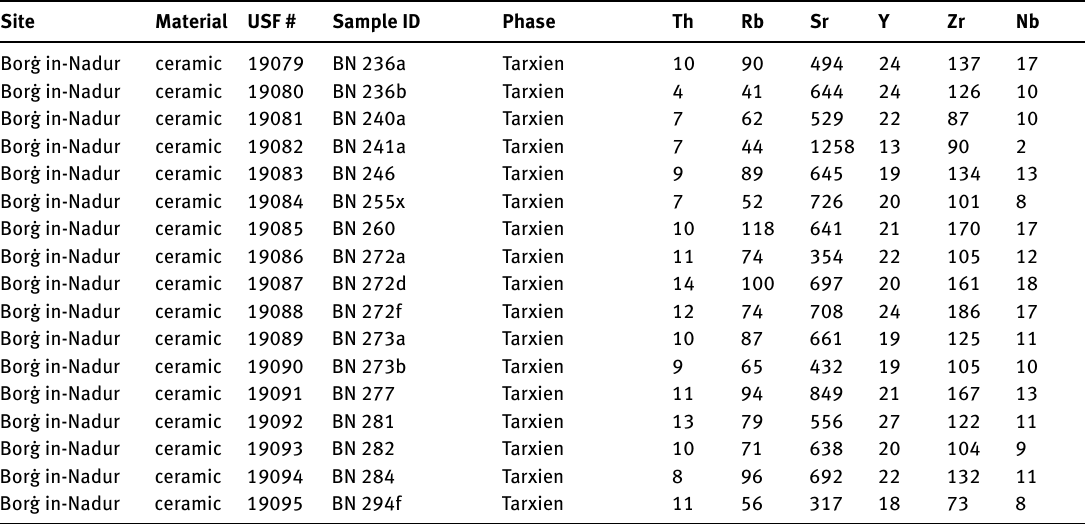
Table 1. Trace elemental compositions for all Maltese and 14 Sicilian (USF #’s 27212 to 27229) ceramic samples and geologi- cal clay samples (Pirone 2017). The remaining 35 Sicilian ceramic samples (USF #’s 18826 to 18857) were analyzed by Robert